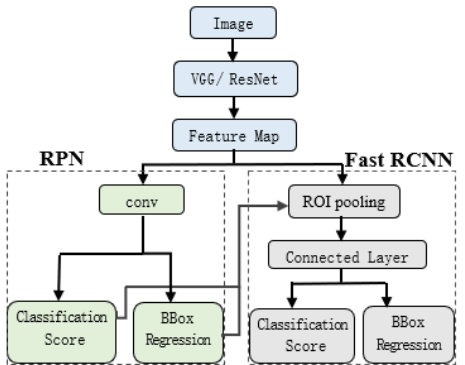
Figure 5. The overall structure of the Faster R ‐ CNN.